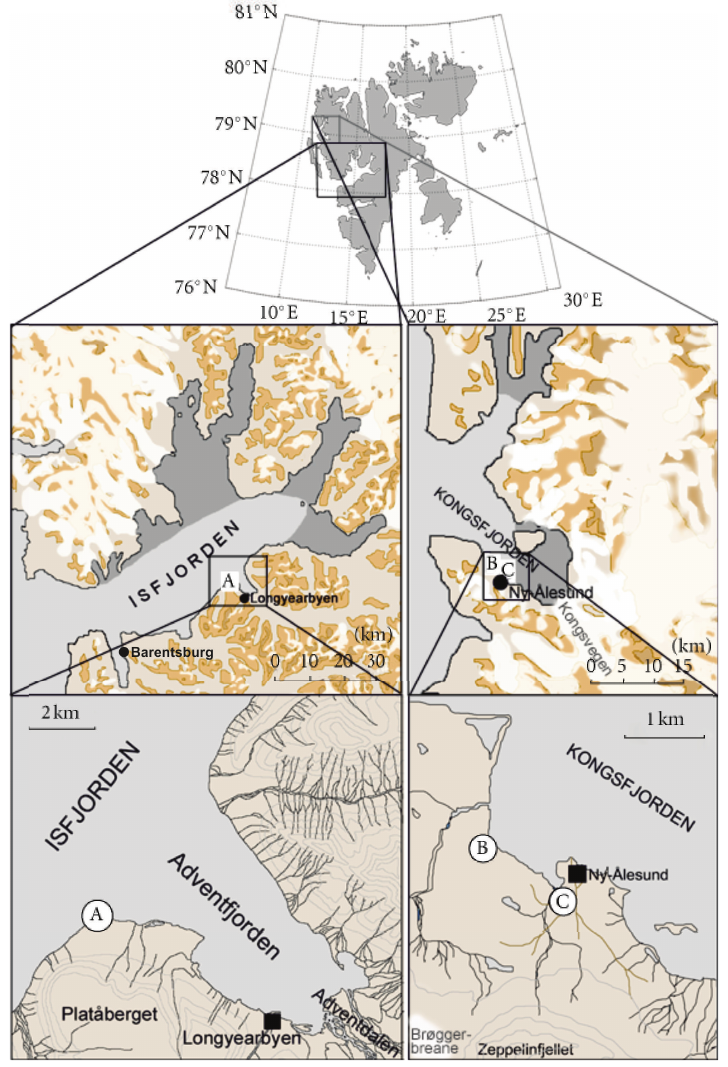
Figure 1: The locations of measurement site of UNIS (A) in Isfjorden, and UT (B) and AWI (C) in Kongsfjorden. In the middle panel, the dark gray shows the areas fully covered with land-fast sea ice and the light gray shows the areas with sea ice concentration varying between 0.2 and 0.9. In the lowest panel, the terrain height is shown with 100 m